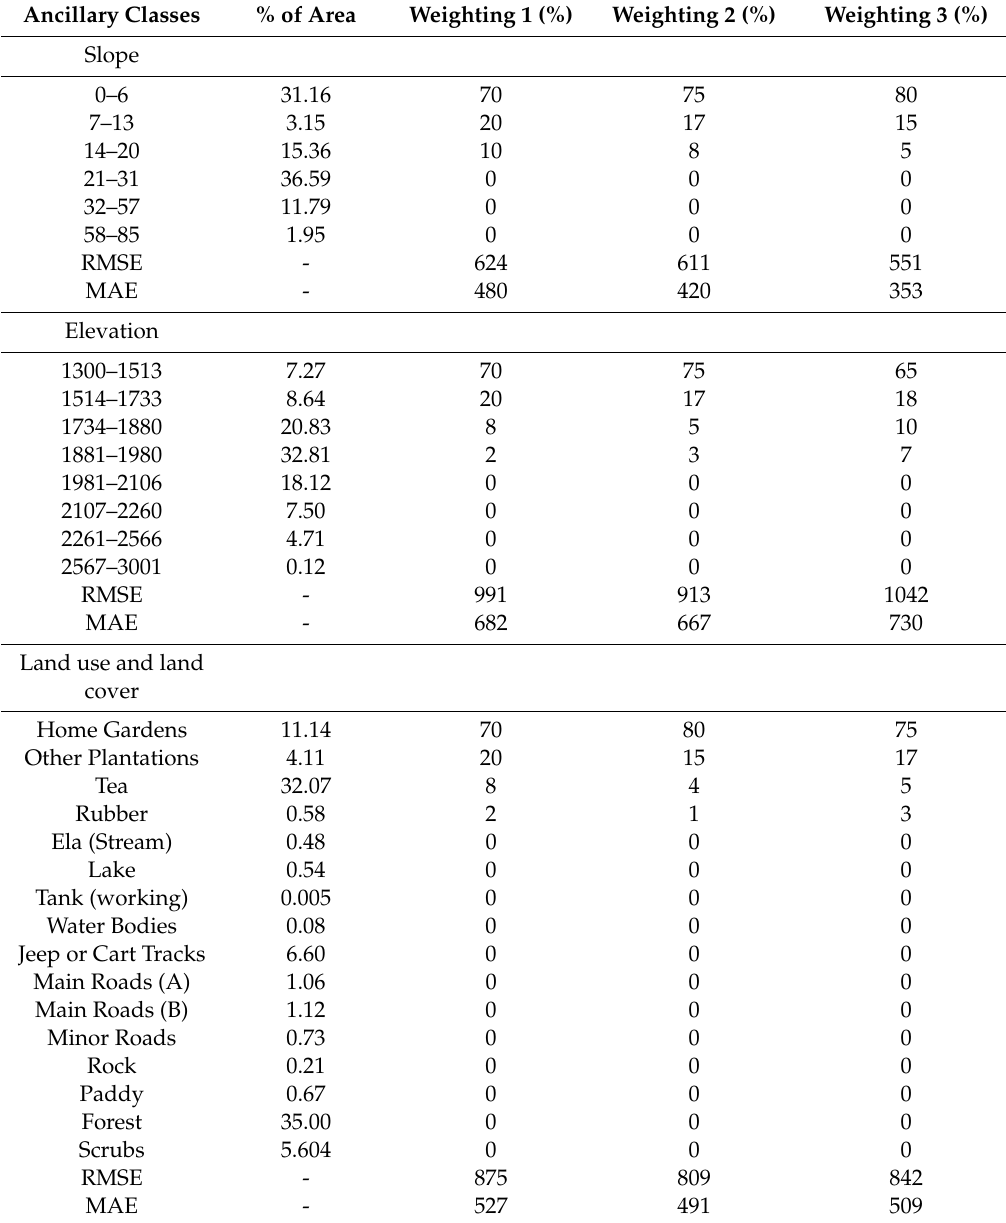
Table 1. Performance in terms of di ff erent weighting schemes for ancillary classes.